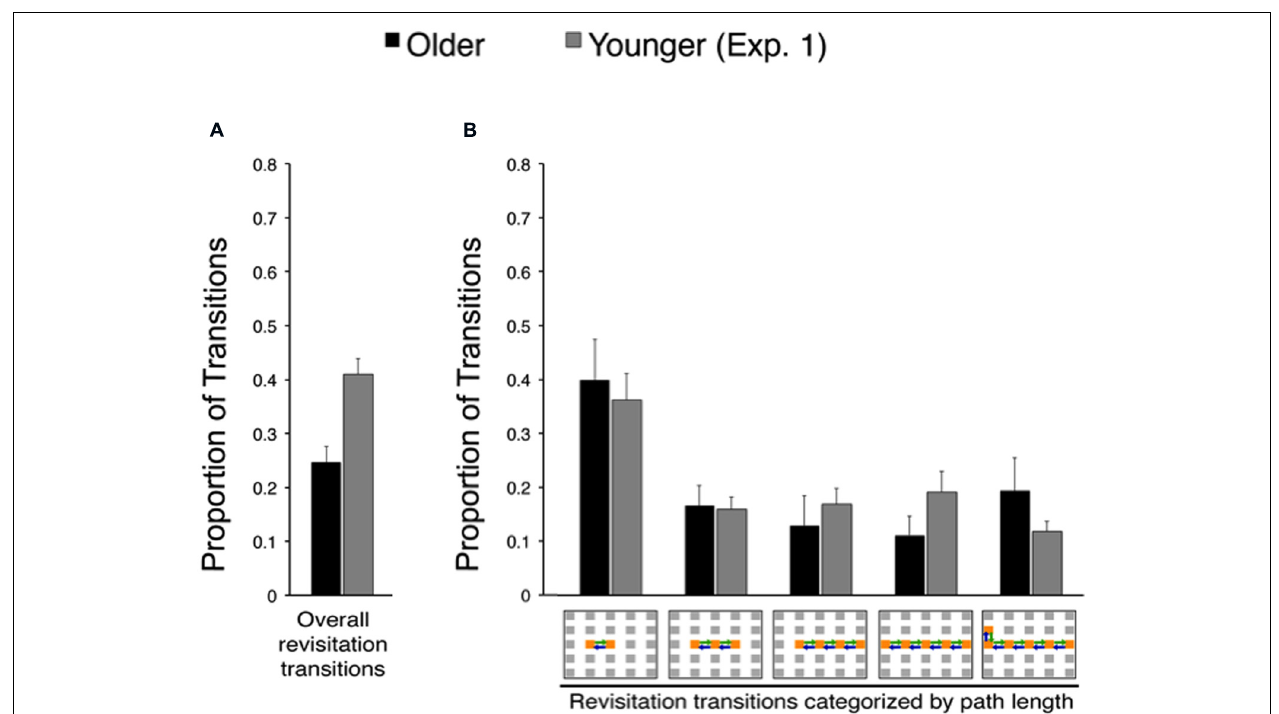
FIGURE 5 | Spontaneous revisitation strategy in Experiment 2. (A) The overall proportion of transitions categorized as involving spontaneous revisitation. (B) The overall proportion of transitions are broken down as a function of the number of objects within each